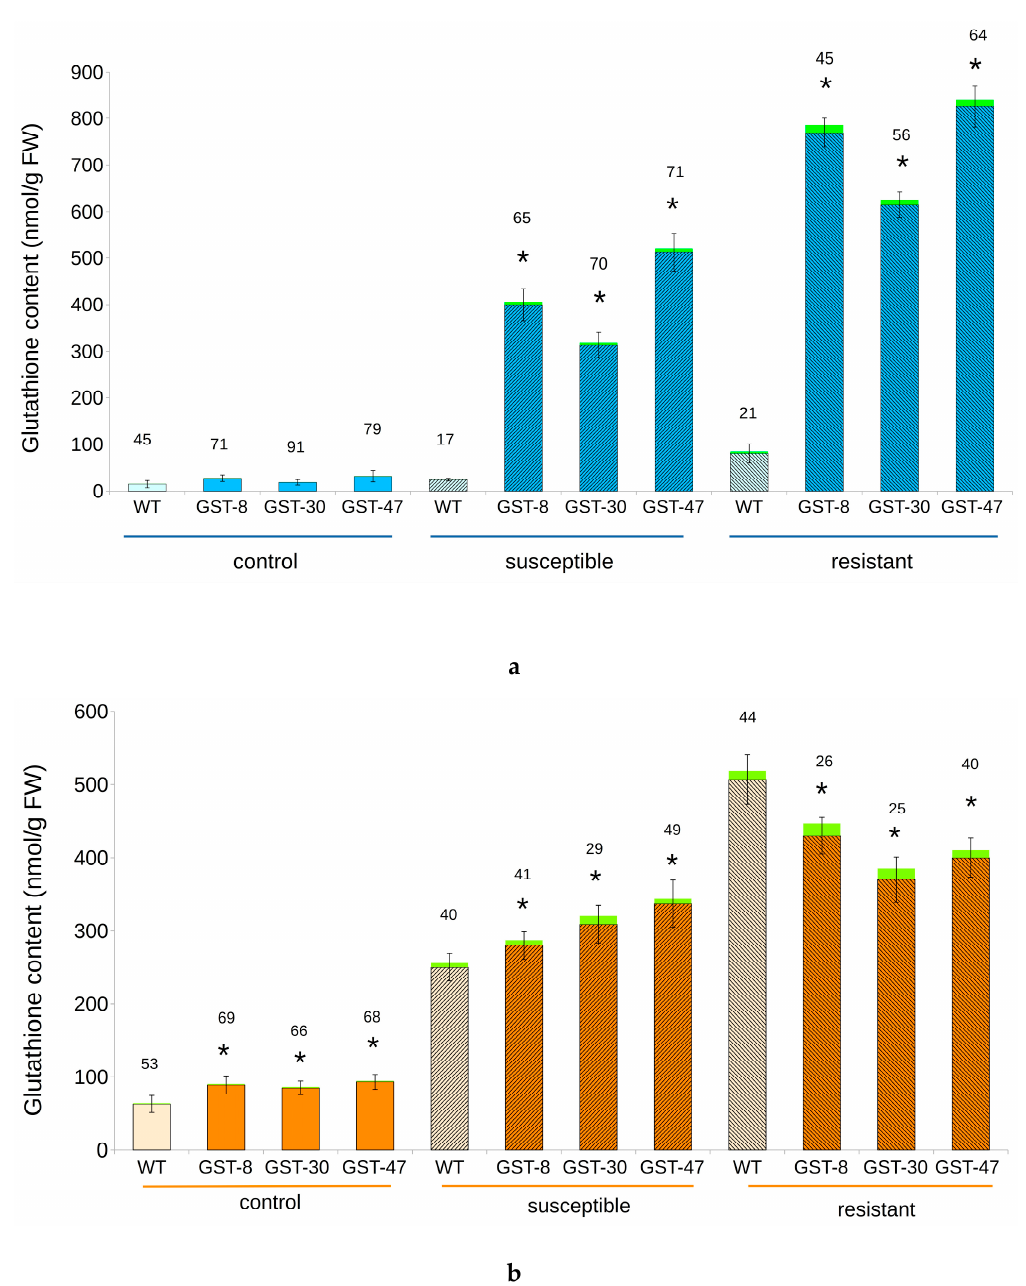
Figure 6. Content of total glutathione, including GSH (blue and orange) and GSSG (green) in transgenic (GST) and WT B. napus exposed to powdery mildew infection. The GSH:GSSG ratio is indicated above each table. ( a ) Experimental plot; ( b ) Laboratory. Visible error bars are calculated for GSH content. Asterisk (*) indicates a significant difference between WT and transgenic plants from the same group.